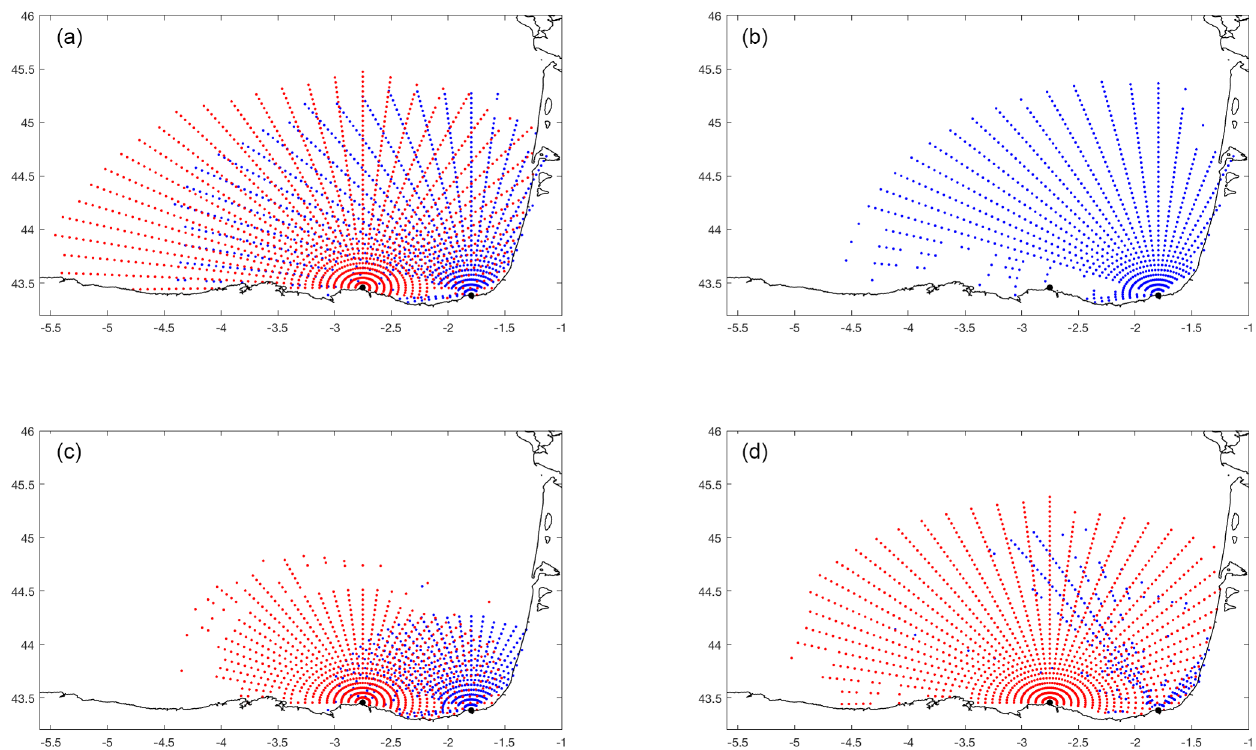
Figure 2. Example of the four prototypes of KMA groups of gap distribution scenarios obtained from the KMA analysis applied to the HFR availability–absence matrix for 2014. Panel (a) represents a good data coverage scenario. Panel (b) accounts for the failure of one of the two antennas. Panel (c) characterizes a range decrease in both antennas. Panel (d) represents bearing coverage decreasing in one of the antennas. Matxitxako radials are plotted in red and Higer radials are plotted in blue (see Fig. S1 in the Supplement for the complete KMA results